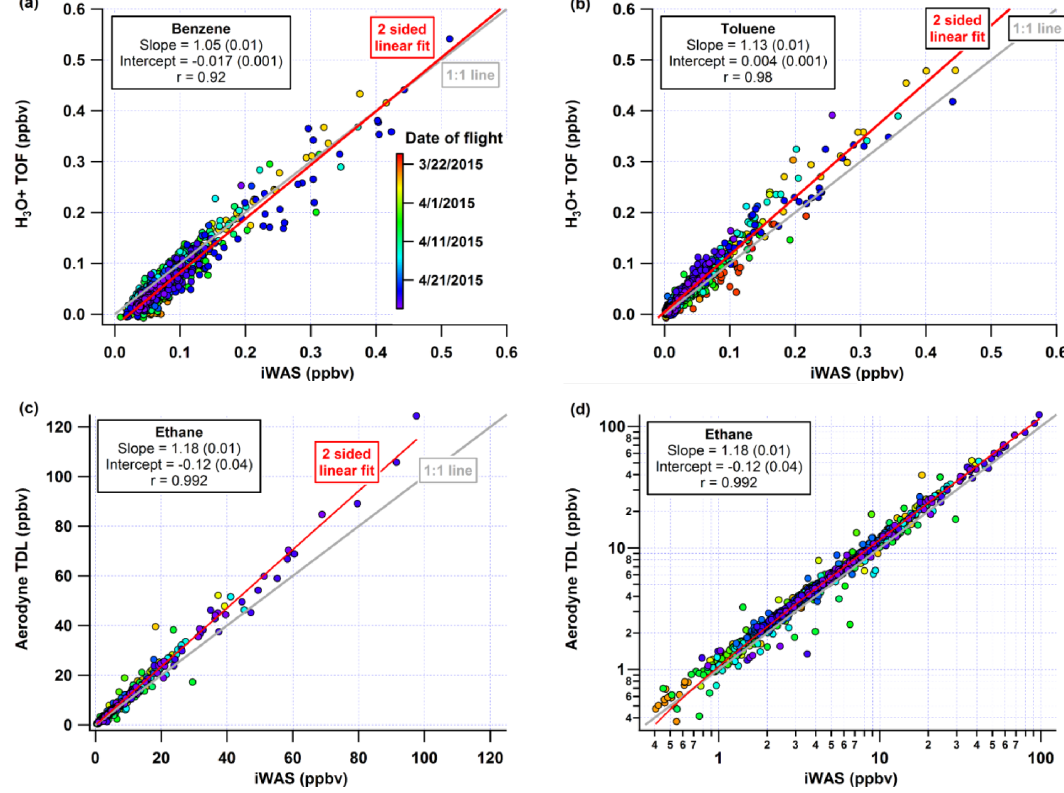
Figure 11. (a–b) Intercomparison with H 3 O + -CIMS of benzene and toluene, respectively, from SONGNEX 2015. Slopes and intercepts from two-sided linear fits of the data are presented, along with correlation coefficients ( r ) from one-sided linear fits. (c–d) Ethane intercomparison for SONGNEX 2015. Slopes and intercepts from two-sided linear fits of the data are presented, along with correlation coefficients ( r ) from one-sided linear fits.